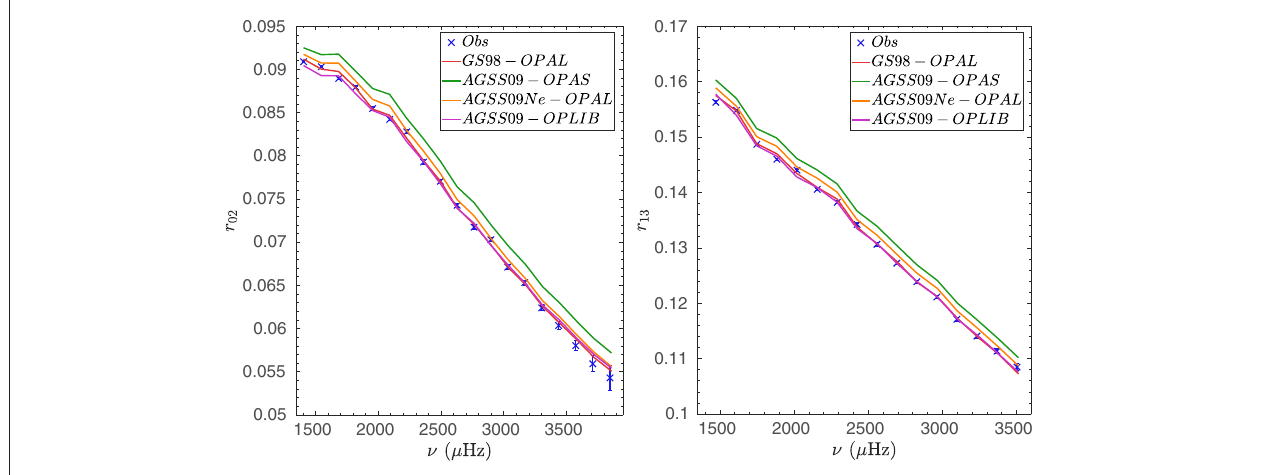
FIGURE 5 | Comparison between the observed frequency separation ratios r 0,2 and r 1,3 from the BiSON data and those of solar models built with various abondance and opacity tables.